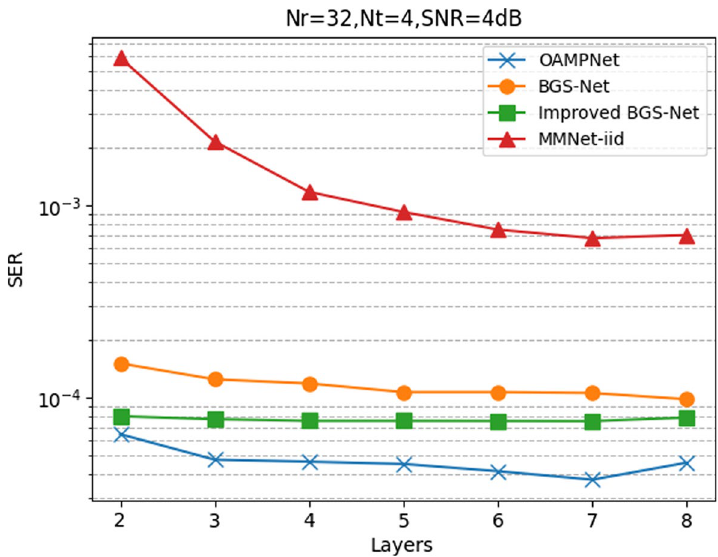
Fig. 17 Effect of number of network layers on SER for N t = 4,N r = 32 , QPSK, MAUE system with ξ r = 0, ξ t =